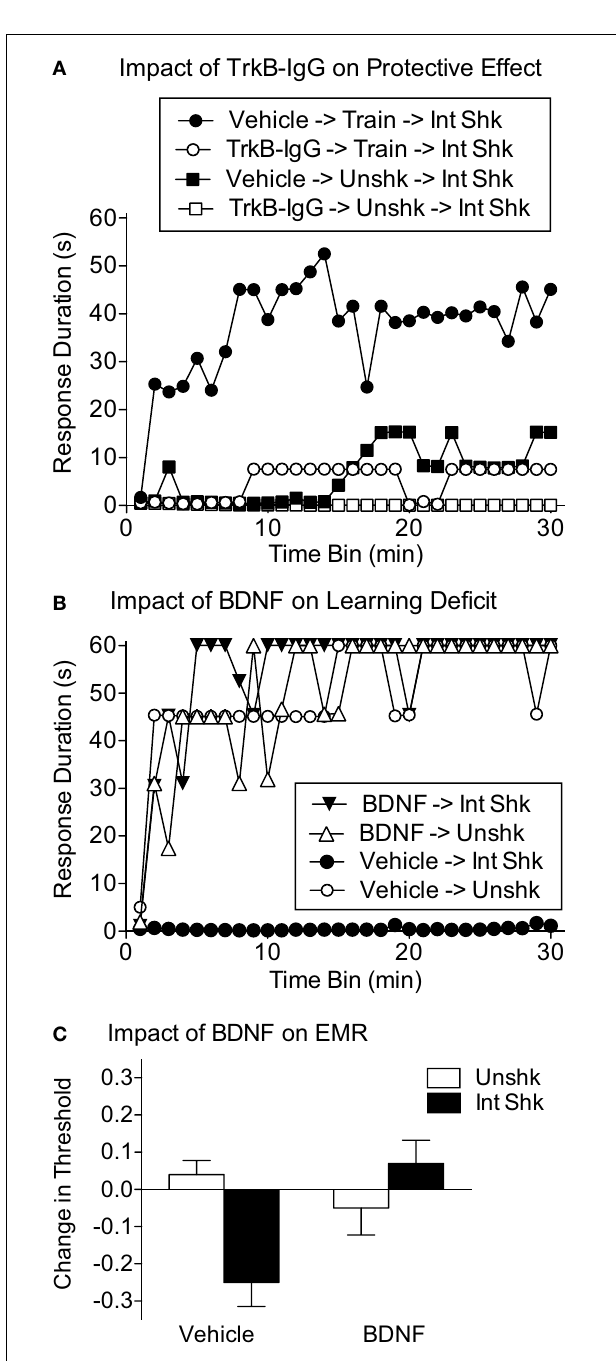
FIGURE 9 | Evidence BDNF contributes to the protective effect of controllable stimulation. (A) Spinally transected rats received the BDNF inhibitorTrkB-IgG (i.t.) or its vehicle, followed by instrumental training (Train) or nothing (Unshk). Subjects then received variable intermittent tail-shock (Int Shk).The next day, subjects were tested with response-contingent shock applied to the previously untrained leg. Intermittent shock induced a learning deficit in the untreated subjects (Vehicle → Unshk → Int Shk). Prior training with controllable shock (Vehicle → Train → Int Shk) prevented the learning deficit. Pretreatment withTrkB-IgG (TrkB-IgG → Train → Shk) eliminated this protective effect. (B) Rats received BDNF (0.4 µ g, i.t.) or